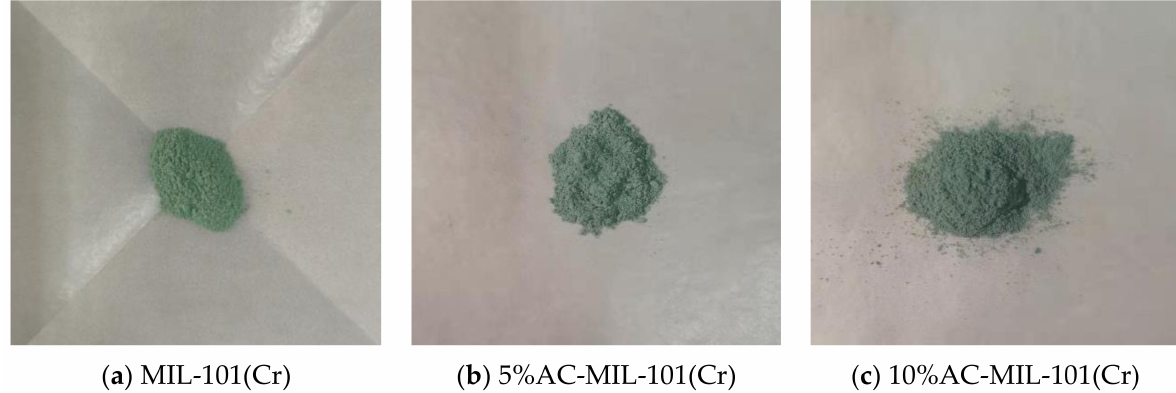
Figure 1. Three sample finished